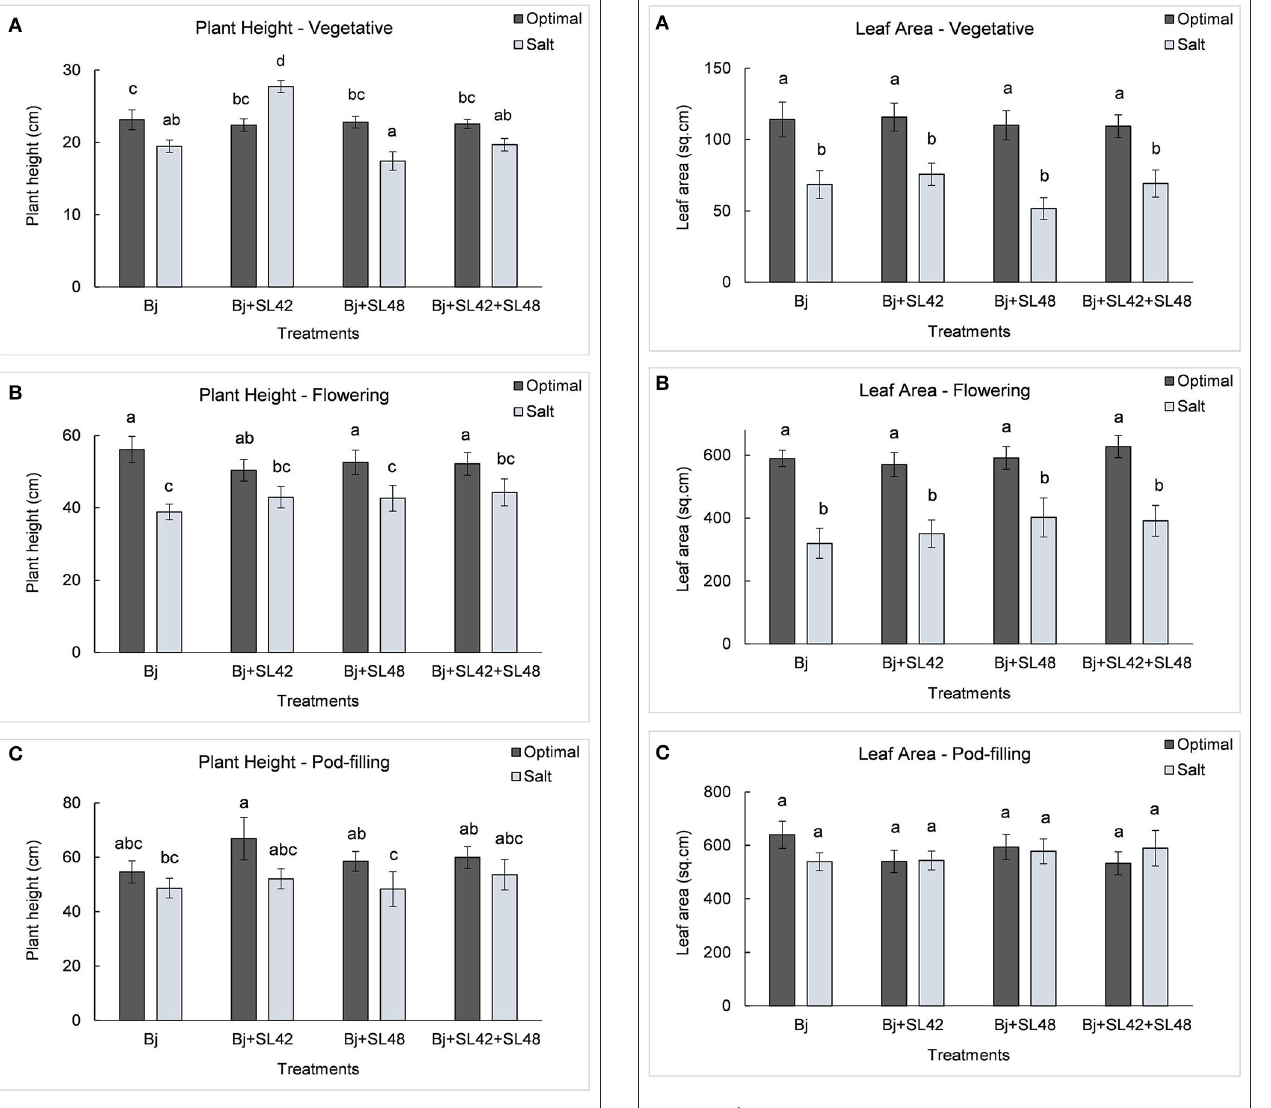
FIGURE 6 | Height of soybean plants measured at (A) mid-vegetative, (B) mid-flowering, and (C) mid-pod-filling stages under optimal (water) and salt (150mM NaCl) conditions. The seeds were bacterized with Bradyrhizobium japonicum (Bj), Bj + SL42, Bj + SL48 and Bj + SL42 + SL48. Values represent mean ± SE (n = 12). Scheffe grouping for least square means was used for multiple means comparison and means with the same letter(s) are not significantly different ( α = 0.05).